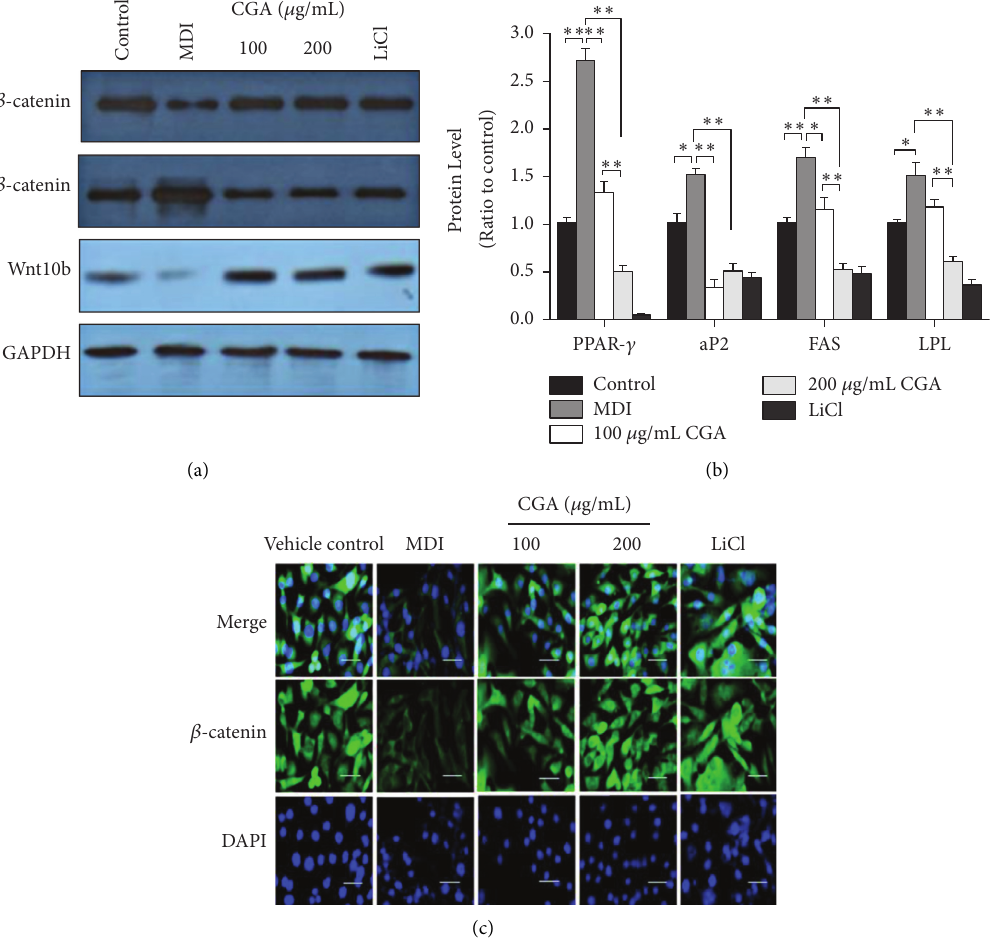
Figure 6: CGA activates the expression of the Wnt/ β -catenin signaling pathway components. (a) Protein expression of β -catenin, non-p- β -catenin, and Wnt10b by Western blot analysis in 3T3-L1 cells. (b) Gene expression of β -catenin, non-p- β -catenin, and Wnt10b in 3T3-L1 cells. Data are presented as means ± SE from three independent experiments. ∗ P < 0 . 05, ∗∗ P < 0 . 01. (c) The expression of β -catenin in 3T3-L1 cells was increased in the groups treated with CGA and LiCl compared with the MDI group, detected by immunofluorescence assay. β -catenin staining is shown as green fluorescence. DAPI staining is shown as blue fluorescence. Scale bars, 100 μ m.